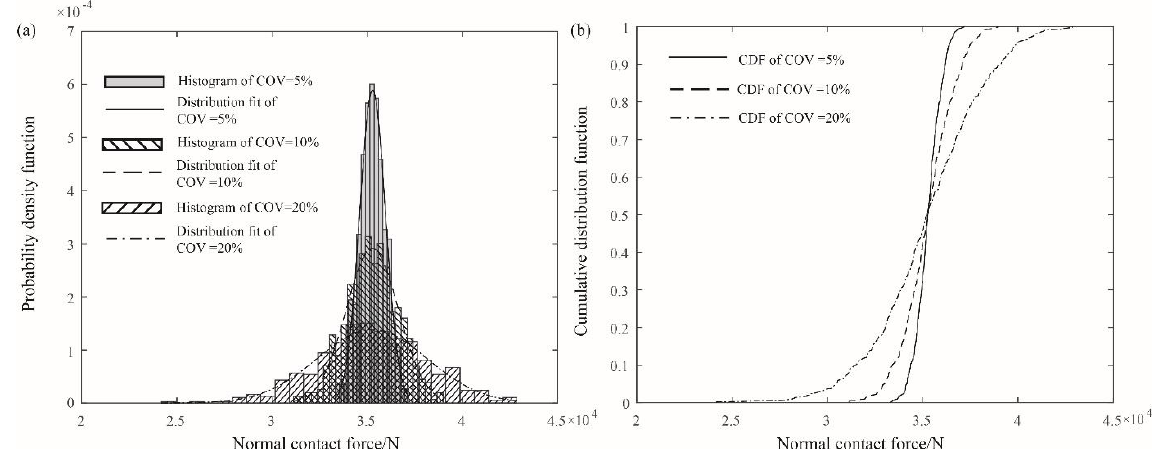
Figure 15. PDFs ( a ) and CDFs ( b ) of the normal contact force at the point A of the elastic block when the COVs are 5%, 10% and 20%.